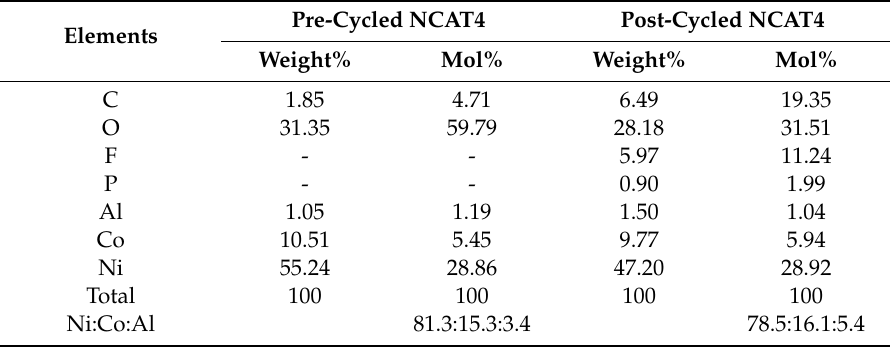
Table 5. Composition of pre-cycled and post-cycled NCAT4 / NCAM2 sample. Elements